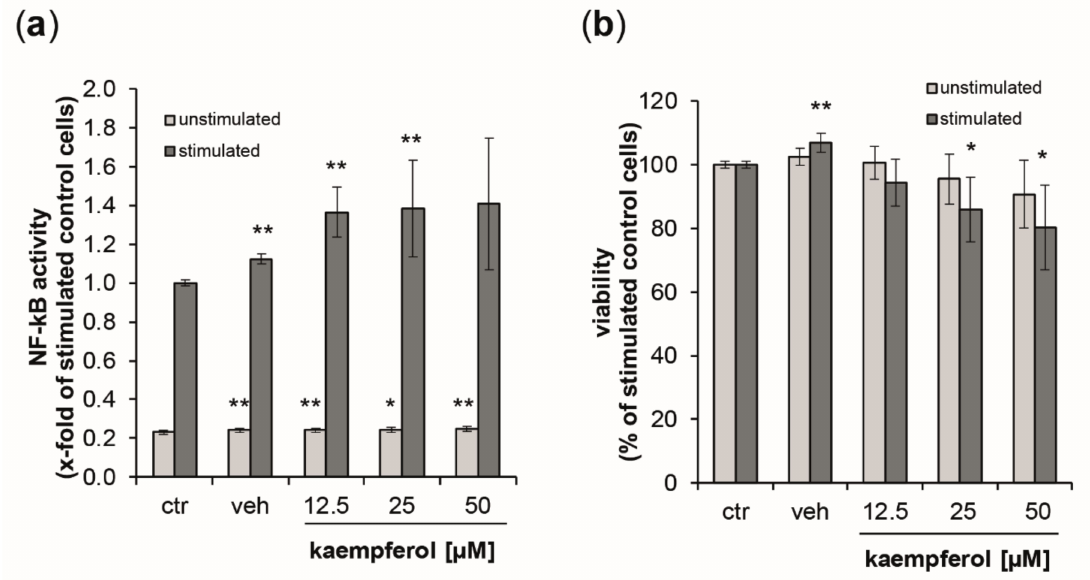
Figure 7. ( a ) Activation of NF- κ B / AP-1 (nuclear factor kappa-light-chain-enhancer of activated B cells / activator protein 1) signaling was analyzed in THP1-Blue reporter cells expressing secreted embryonic alkaline phosphatase (SEAP) upon stimulation. Light grey bars represent unstimulated cells, while dark grey bars indicate stimulation with 100 ng / mL of lipopolysaccharide LPS. Cells were left either untreated or were incubated with increasing concentration of kaempferol or the solvent control. SEAP activity was assessed after 24 h. ( b ) E ff ect of kaempferol on THP1-Blue viability at 24 h post-treatment. Cell viability is shown in comparison to the stimulated bu ff er control (ctr, set to 100%). Shown are mean values of six independent experiments performed in triplicates (mean ± S.E.M). * p values < 0.05 and ** p < 0.005 indicate significant changes compared to the respective unstimulated or LPS-stimulated solvent